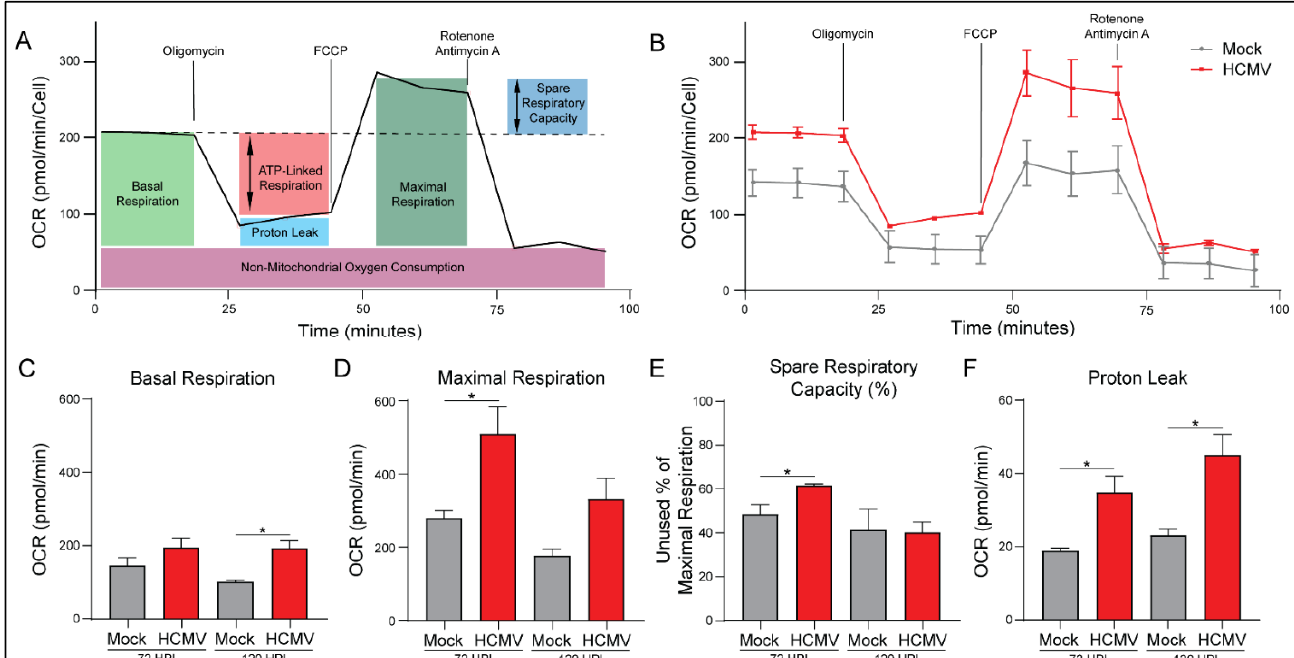
Figure 3. HCMV infection increases oxidative phosphorylation in LN-18 cells. ( A ) A cartoon illustrating how mitochondrial function was measured at 72 and 120 h post infection (HPI) using the Seahorse XFe24 MitoStress Kit. ( B ) Representative data output of LN-18 cells mock- or HCMV-infected at 72 HPI. ( C ) Basal Respiration, ( D ) Maximal Respiration, ( E ) Spare Respiratory Capacity, and ( F ) Proton Leak were derived from these measurements. All samples were normalized to cell number. Graphs represent pooled data from three independent experiments. Mean ± the SEM of at least 3 triplicates. *, p < 0.05.